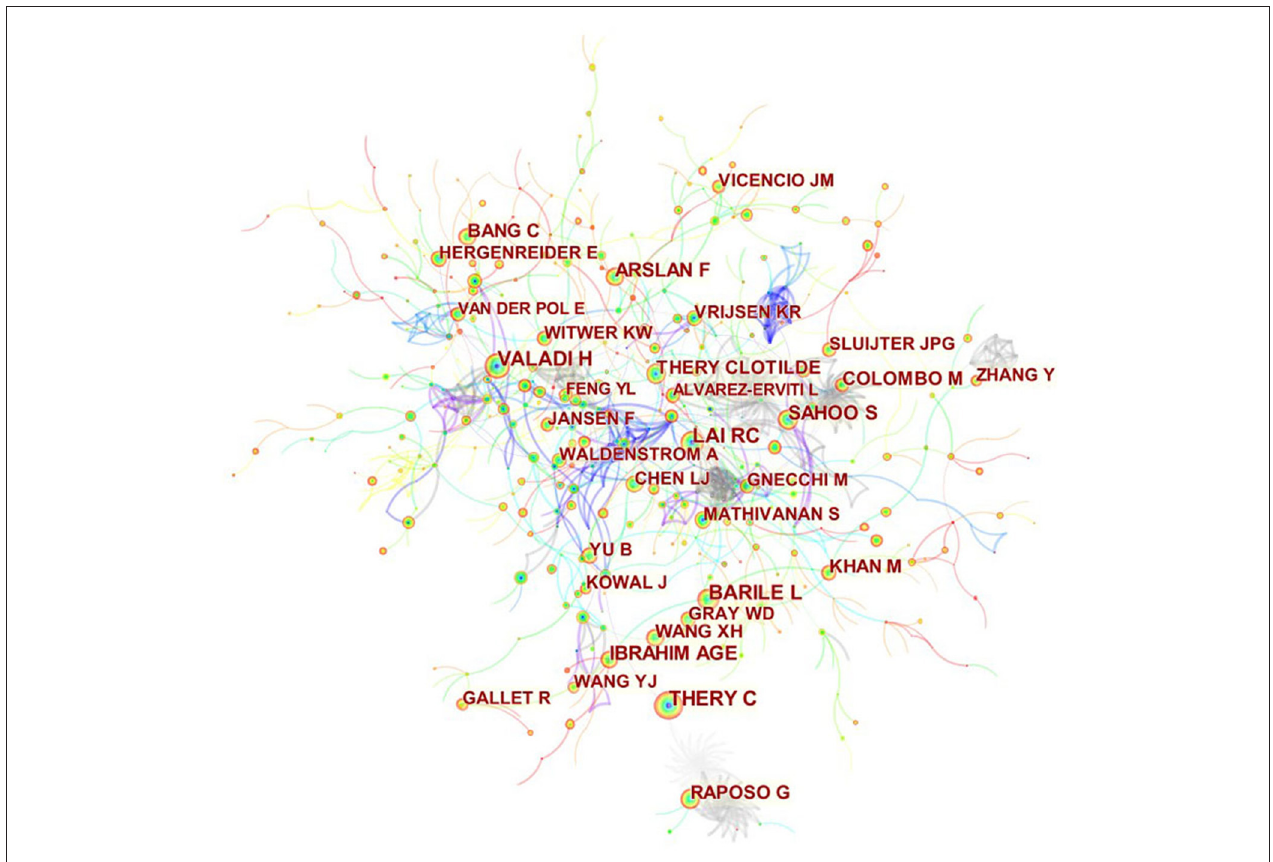
FIGURE 7 | CiteSpace visualization map of co-cited authors involved in exosomes in CVDs.